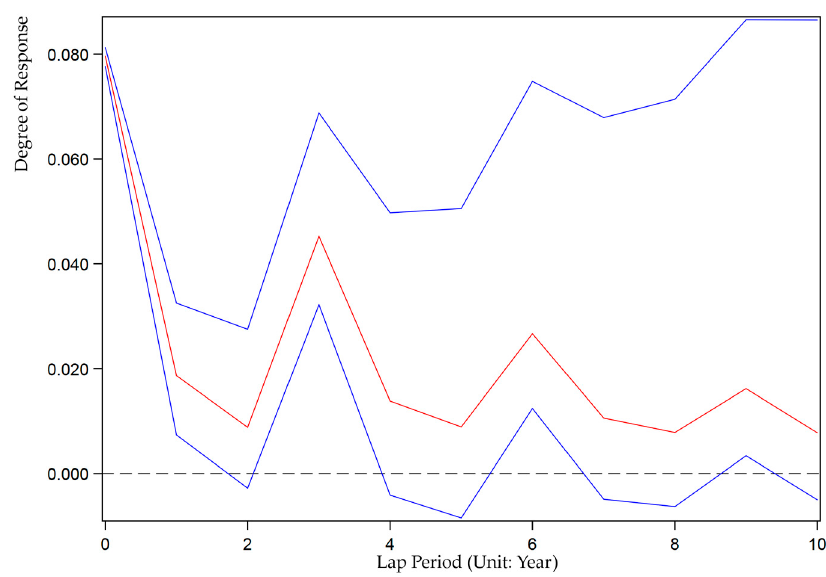
Figure 5. Impulse response of GEE to